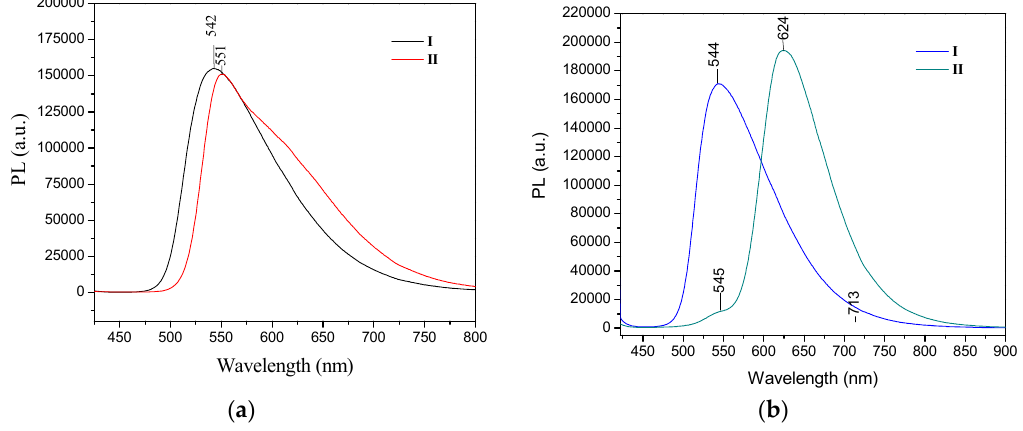
Figure 10. PL spectra of compounds I – II in ( a ) powder and ( b ) in crystal forms. Excitation wavelength for both conditions was 405 nm.